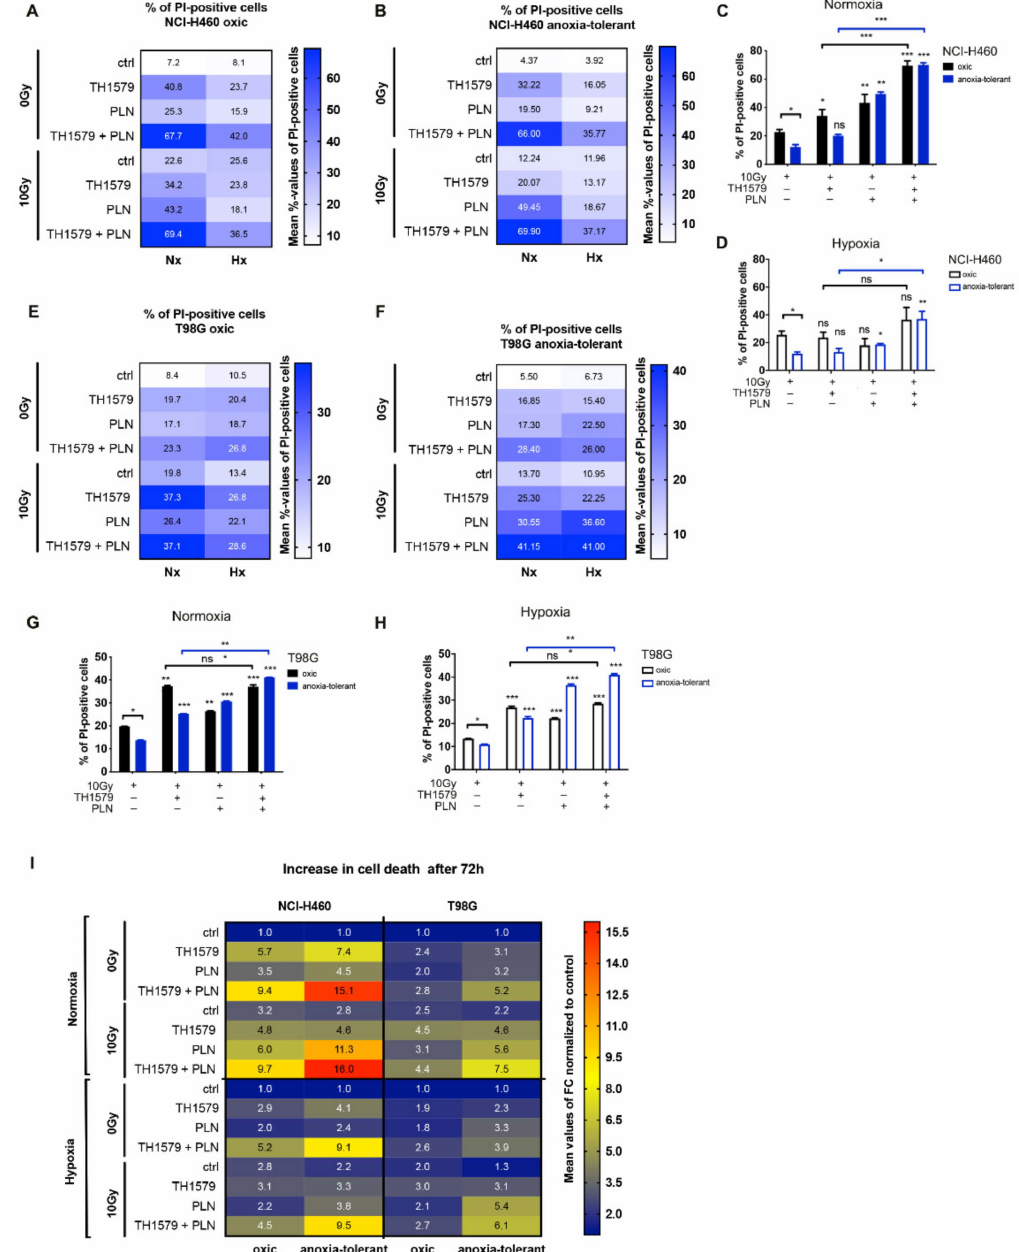
Figure 1. Inhibition of MTH1 combined with inhibition of glutathione regeneration overcomes cell death resistance induced by adaptation to chronic-cycling hypoxia. Impact of MTH1 inhibition by TH1579 (1 µ M) alone and in combination with PLN (10 µ M) and exposure to ionizing radiation (IR, 10 Gy) on cell death under normoxic (Nx) and hypoxic (Hx) conditions was examined. ( A , B ) Heatmap representing mean % of measured Propidium iodide (PI)-positive NCI-H460 oxic control ( A ) and anoxia-tolerant ( B ) cell lines under Nx and Hx. ( C , D ) Fraction of dead (PI-positive) NCI-H460 cells 72 h after respective inhibitor treatments with 10 Gy IR under Nx ( C ) and Hx ( D ) determined by flow cytometry. ( E , F ) Heatmap representing mean % of PI-positive T98G oxic control ( E ) and anoxia-tolerant ( F ) cell lines under Nx and Hx. ( G , H ) Fraction of PI-positive T98G cells 72 h after respective inhibitor treatments with 10 Gy IR under Nx ( G ) and Hx ( H ). ( I ) Representation of the treatment-induced increase in cell death in anoxia-tolerant and respective oxic control NCI-H460 and T98G cancer cells under normoxia and hypoxia. Cell death levels were normalized to levels of untreated controls and represented as fold changes (FC) in a heat map. Measured mean % of PI-positive cells used to calculate FC can be found in Supplementary Materials Figure S1E. Mean values ± SEM are shown, n = 3–5 (ns: not significant, * p ≤ 0.05, ** p ≤ 0.01, *** p ≤ 0.001; t -test or 2-way ANOVA with Tukey post-test where